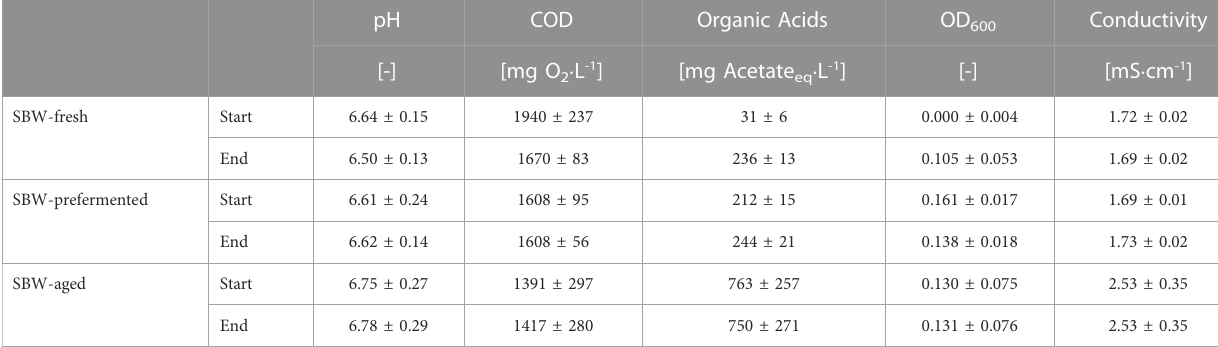
TABLE 2 Wastewater characteristics before and after the polarization curve experiments averaged over the four